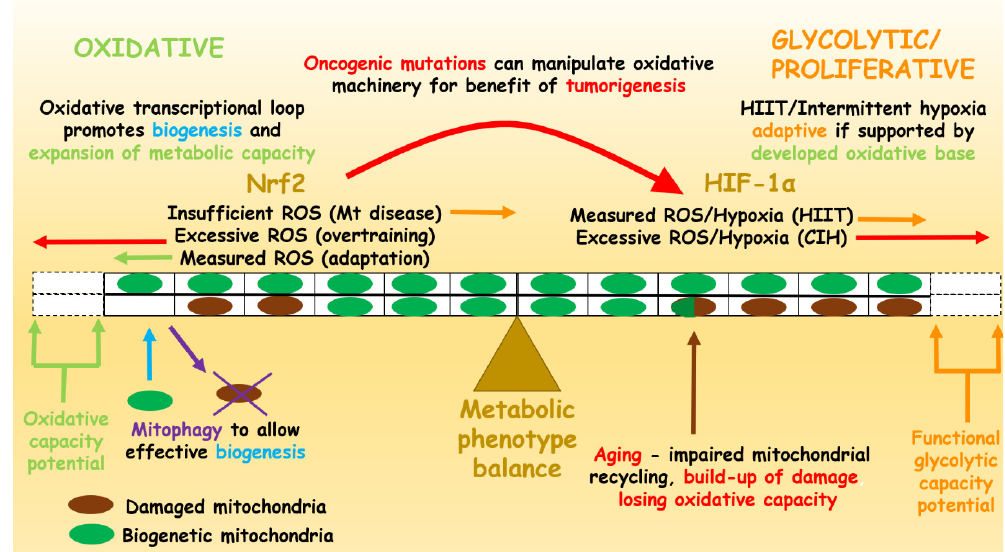
Figure 5. Model of metabolic phenotype balance. Light green arrows indicate pro ‐ oxidative adaptation, yellow—pro ‐ gly ‐ colytic/proliferative adaptation, and red—maladaptation due to over ‐ load of endogenous antioxidant system or malignant ROS signalling in cancer. Mt: metabolic; HIIT: high ‐ intensity interval training; CIH: chronic intermittent hypoxia.